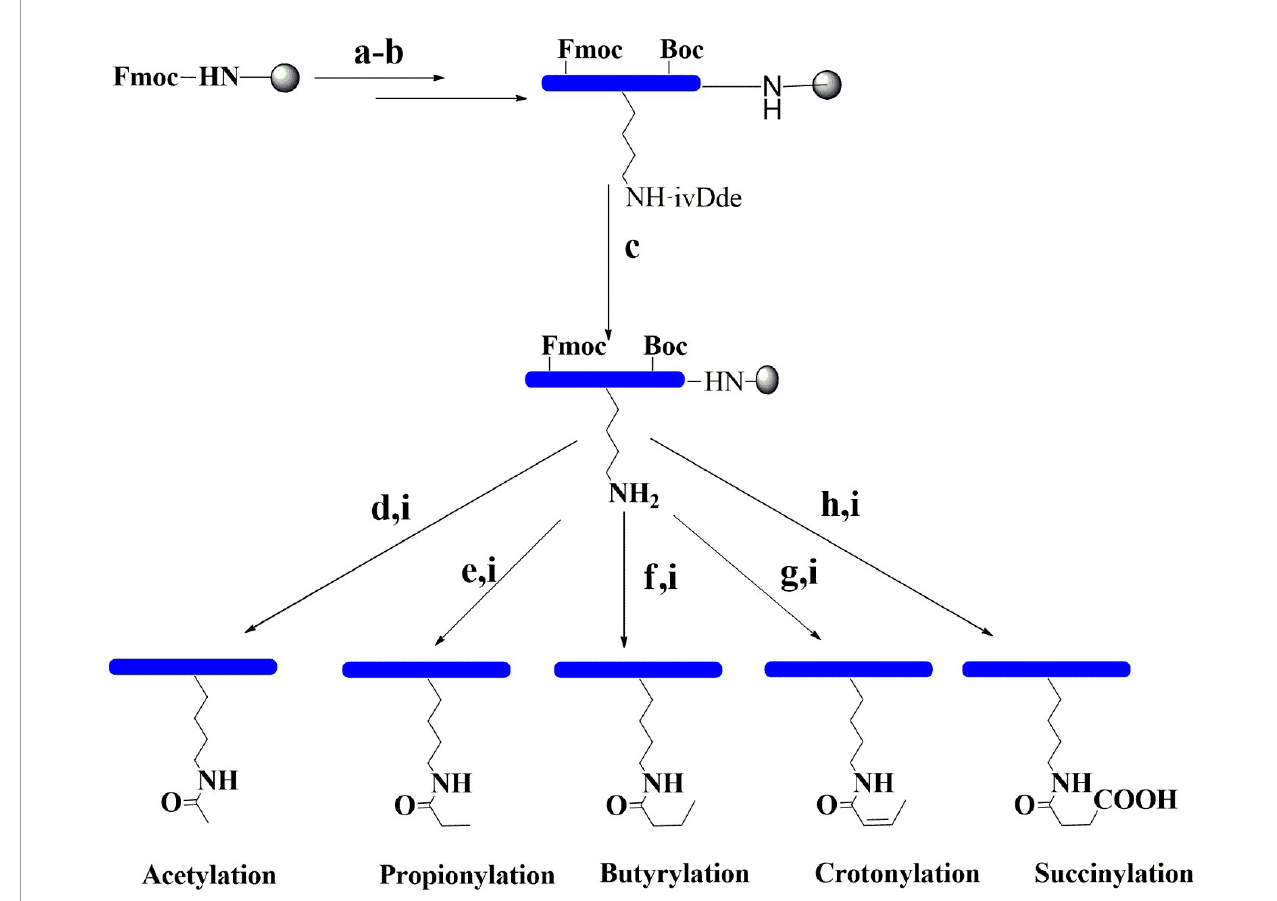
FIGURE 2 | Synthetic pathways for the preparation of modi fi cation peptides. (a) With 20% piperidine/DMF. (b) Fmoc amino acid, HBTU, HOBT, and DIPEA. (c) With 4% hydrazine and DMF. (d) With 10% acetic anhydride and toluene. (e) With 10% propionic anhydride and toluene. (f) With 10% butyric anhydride and toluene. (g) With 10% crotonic anhydride and toluene. (h) With 10% succinic anhydride and DMF. (i) With 95% TFA, 2.5% TIS, and 2.5% H 2 O. DIPEA , N , N - diisopropylethylamine; DMF , N , N -dimethylformamide; Fmoc , fl uorenylmethyl carbamate; Boc , tert -butyloxycarbonyl; HOBT , hydroxybenzotriazole; HBTU , N , N , N 9, N 9- tetramethyl- O -(1 H -benzotriazol-1-yl)uronium hexa fl uorophosphate; TFA , tri fl uoroacetic acid; TIS ,